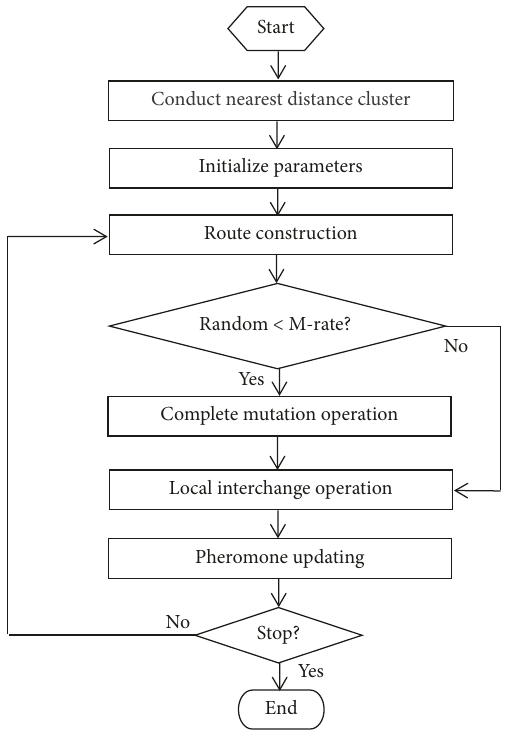
Figure 2: The flowchart of HACO.